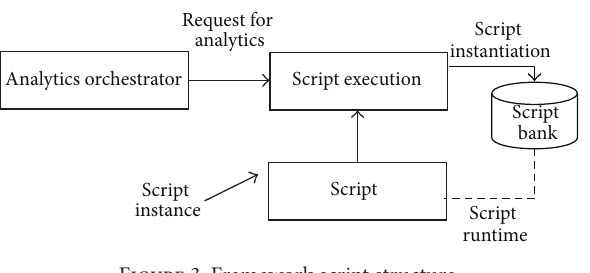
Figure 3: Framework script